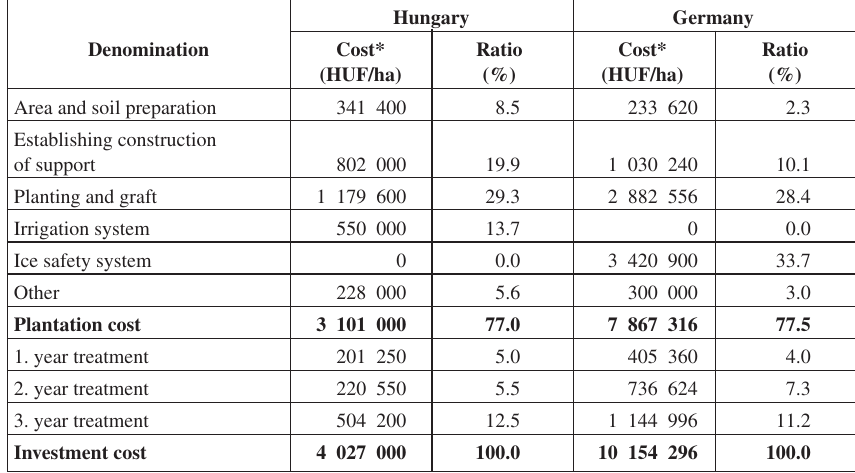
Table 1. Comparing the Investment